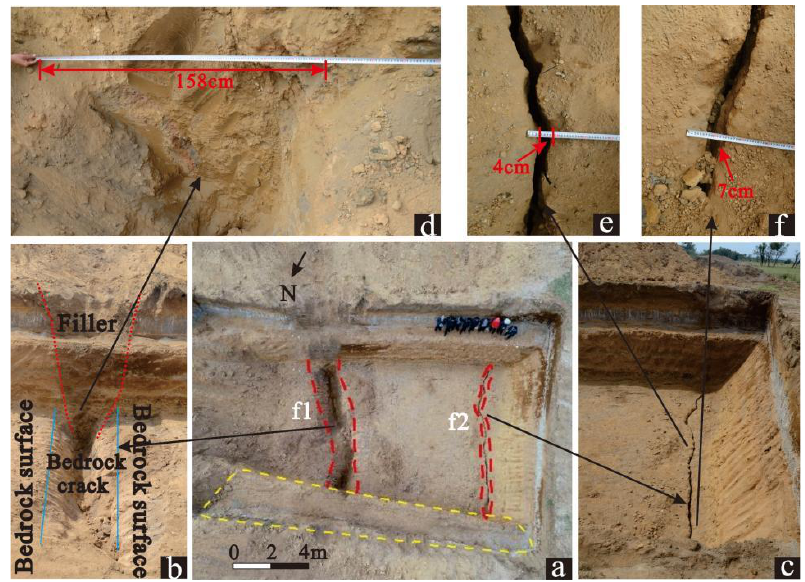
Figure 10. Bedrock cracks in Trench 1. ( a ) Top view of the exploratory trench; ( b ) f1 bedrock crack morphology; ( c ) f2 bedrock crack morphology; ( d ) f1 bedrock crack details; ( e ) and ( f ) f2 bedrock crack details.